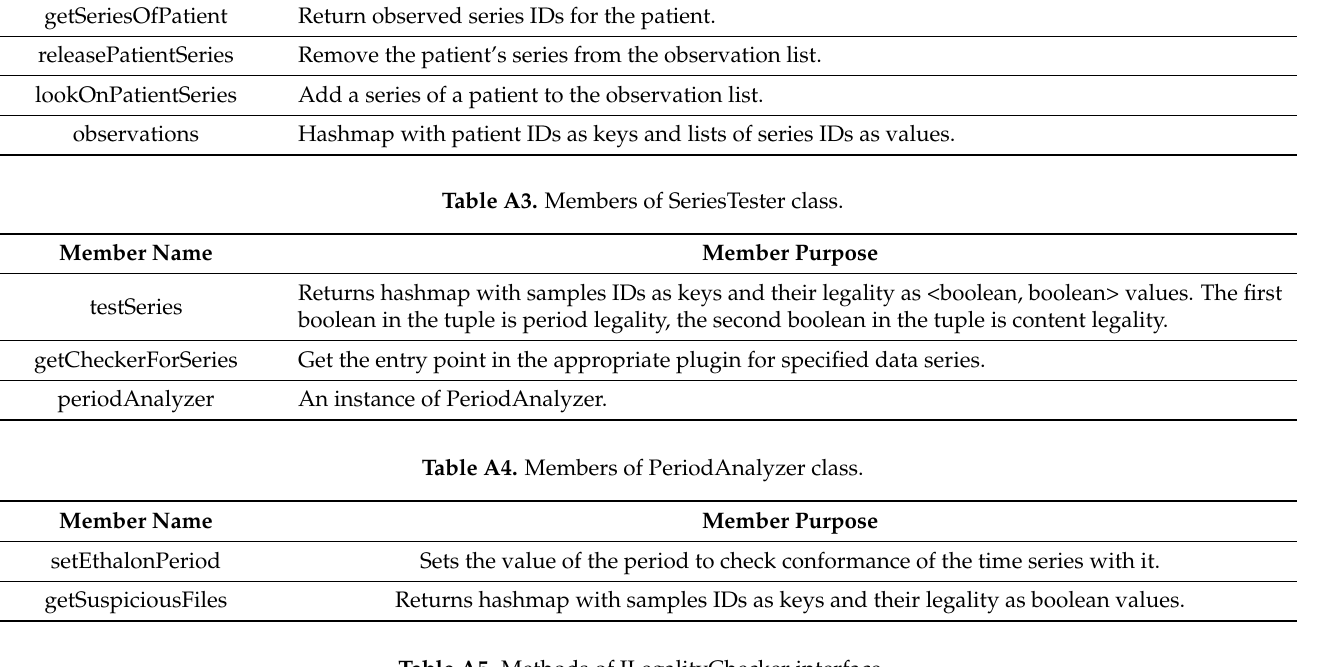
Table A5. Methods of ILegalityChecker interface.